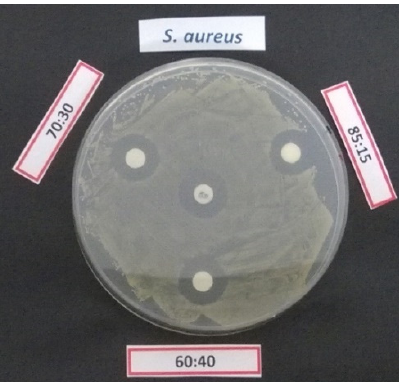
Figure 5. Inhibition halos produced by gentamicin against S. aureus DSM799 released by cellulose disks coated with different iCVD polymers of different crosslinker content (as reported in the labels). The positive disk control (10 µg gentamicin/disk) is in the center.